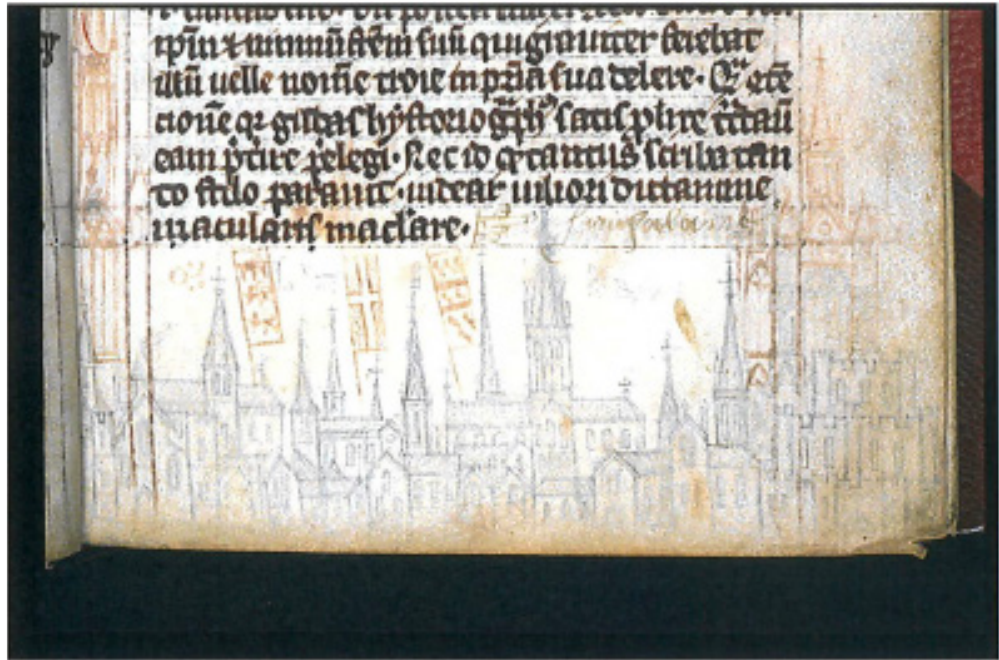
Fig. 1. Drawing of London in lead and ink, probably fourteenth century. London, British Library, Royal MS. 13 A. III, f. 14r.